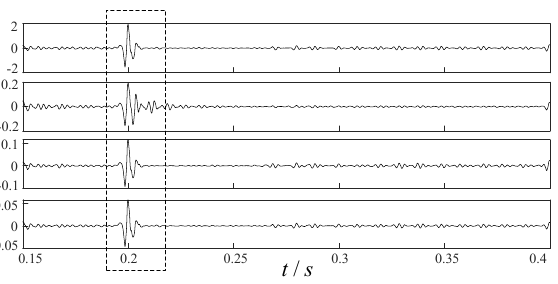
Figure 11. Waveform of wavelet packet coefficient (when the fault occurs on the bus).